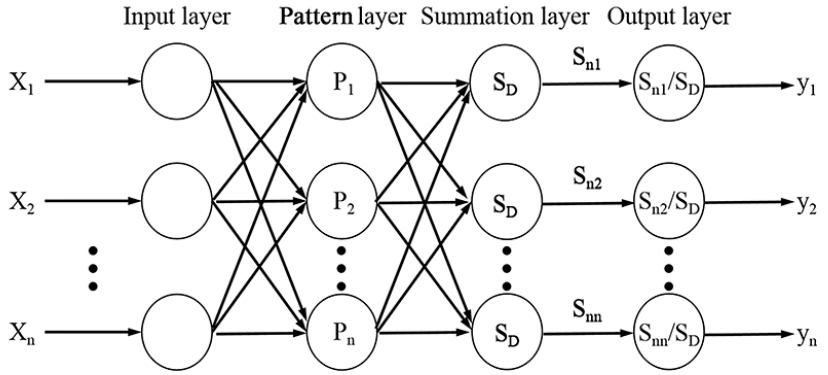
Figure 5. Structure of the generalized regression neural network (GRNN).